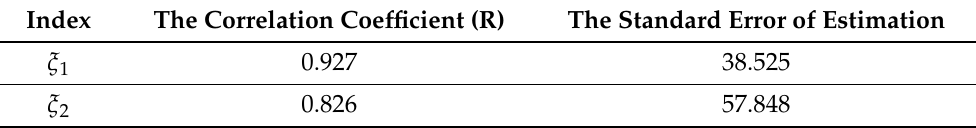
Table 2. The correlation coefficient (R) and standard error